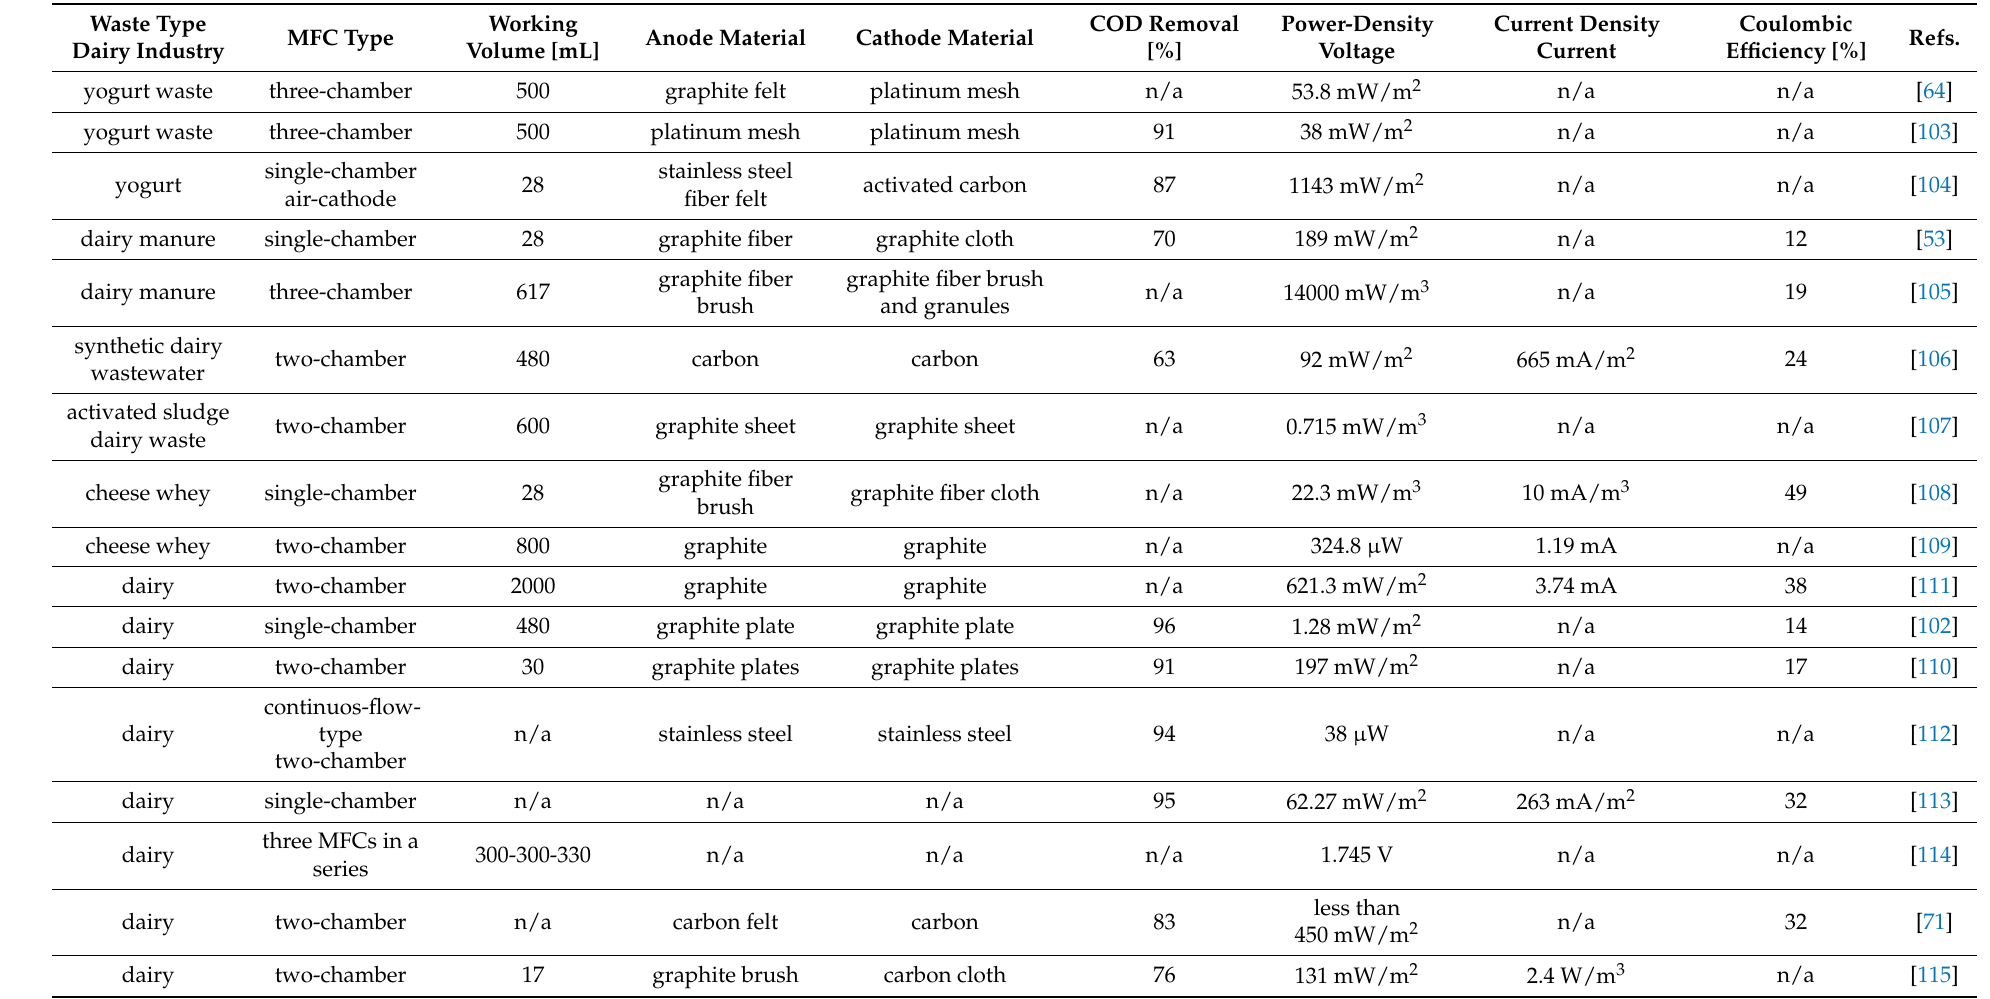
Table A3. Summary of studies reporting use of dairy waste in